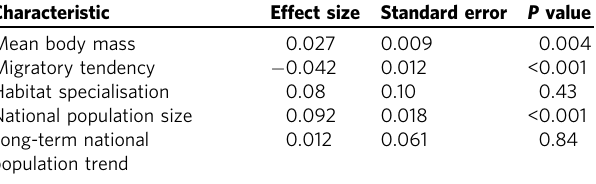
Table 1 Relationships between species characteristics and associations with road